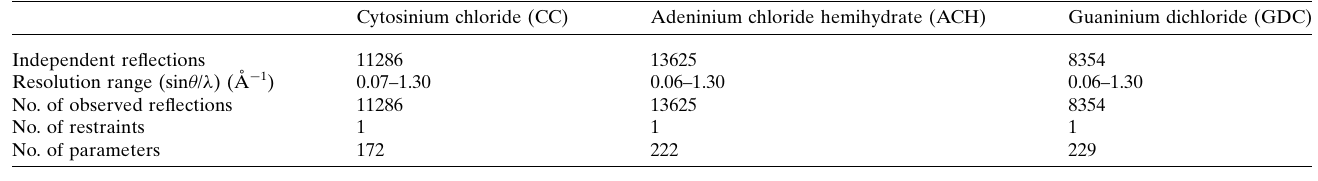
Table 2 Parameters characterizing multipole refinement against theoretical structure